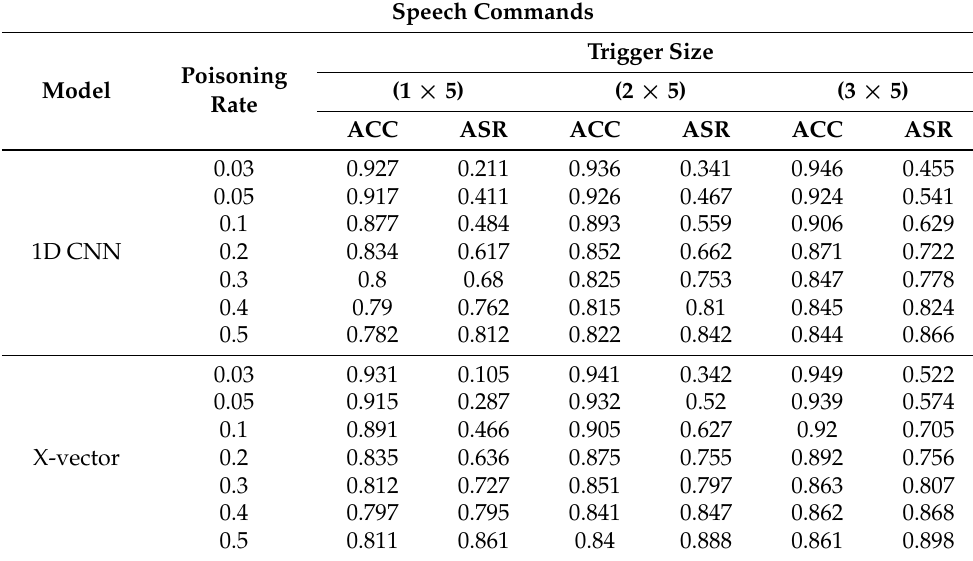
Table 4. The results of the accuracy and attack success rate for the speech commands